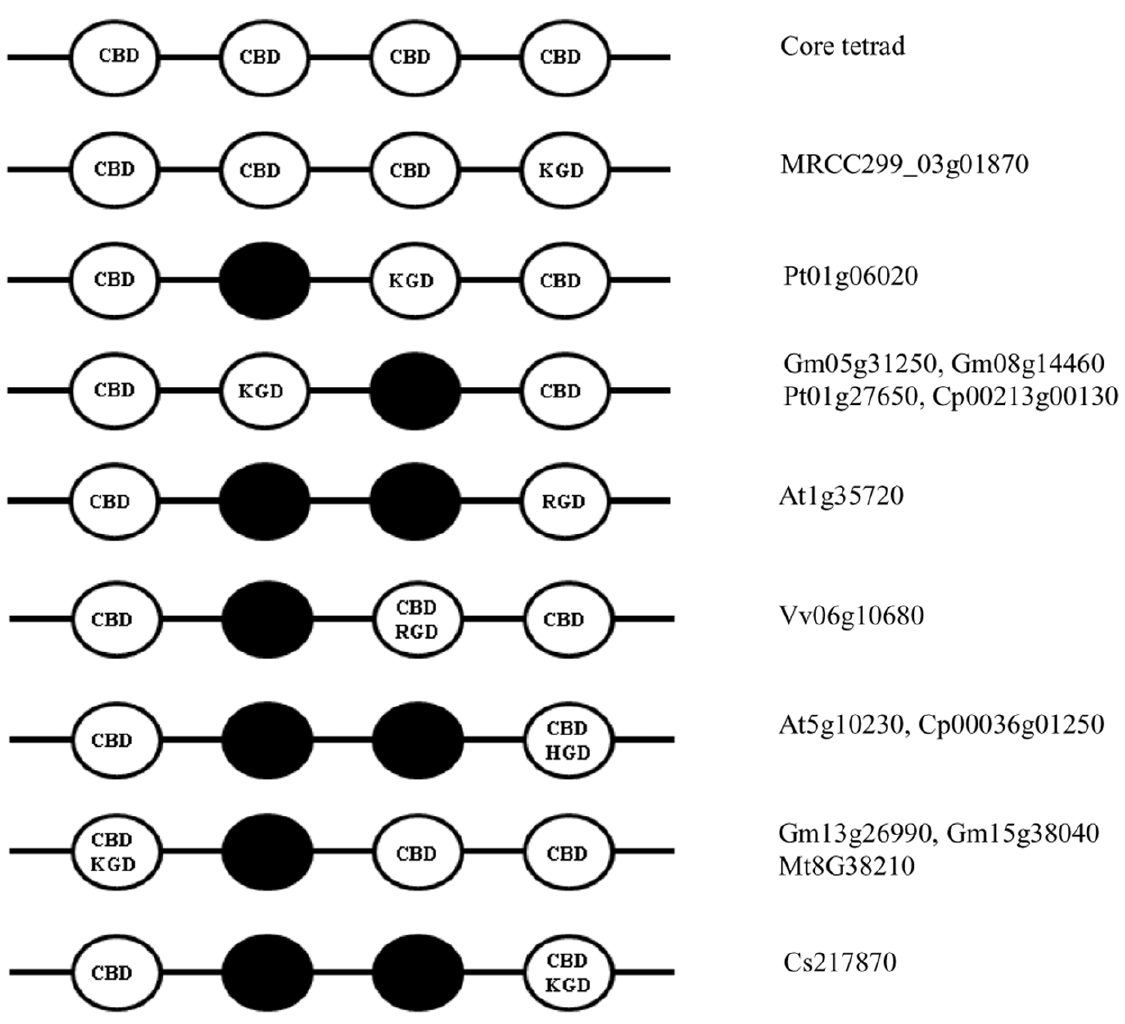
Figure 6. Domain organizations showing the presence or absence of CBS. Anx domain structures showing CBS and K/H/RGD motifs. The occurrence of these motifs in different genomes was analyzed from all deduced proteins. Dark circles represent the absence of CBS or K/H/RGD motifs. Domain structures are not drawn to scale.